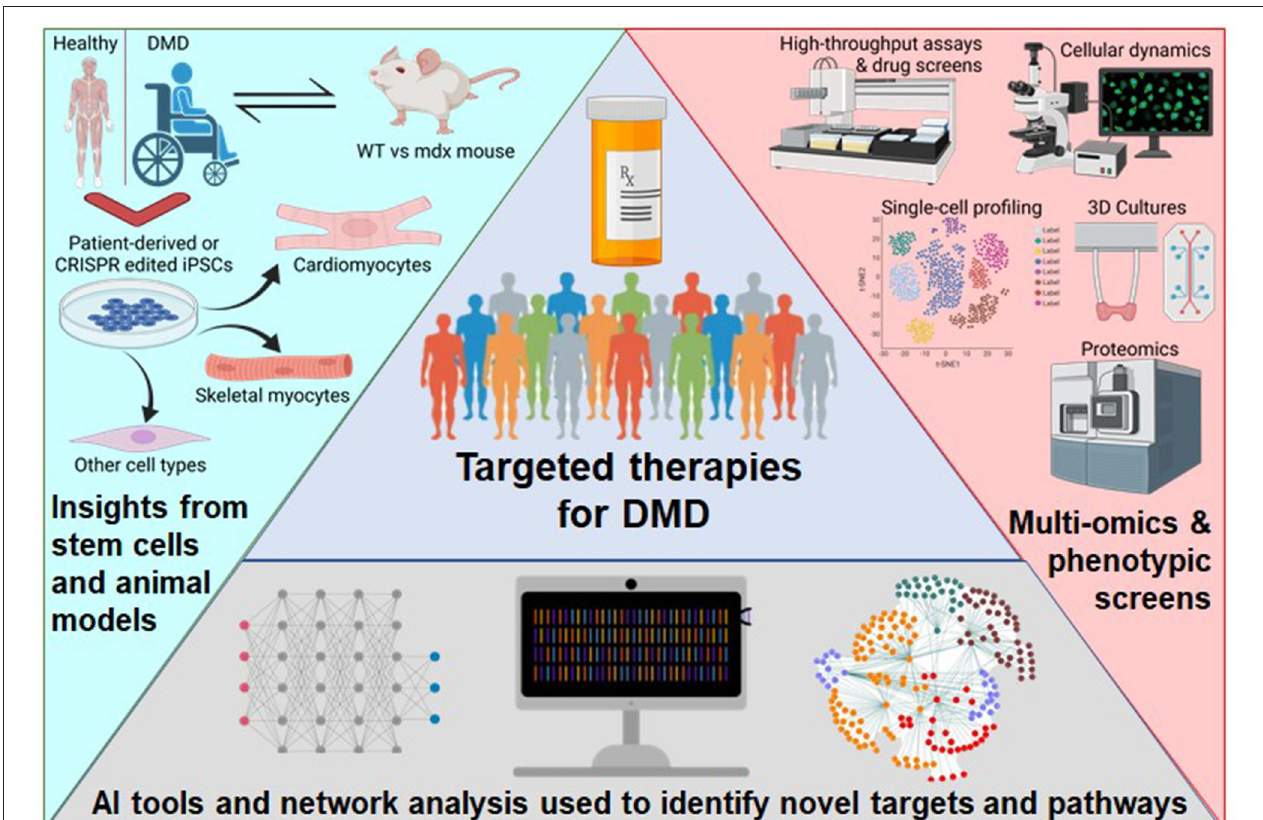
FIGURE 1 | Schematic of the approaches to broaden the therapeutics available to DMD patients. Patient-derived or genome-edited iPSCs provide a human model for disease specific modeling of various cell types and benefits from previous knowledge using the mdx mouse. Newer experimental technologies are detailing the intricacies of complex phenotypes. Next-generation computational tools are enabling high-dimensional analysis of multi-omics data. This figure was created with BioRender.com.